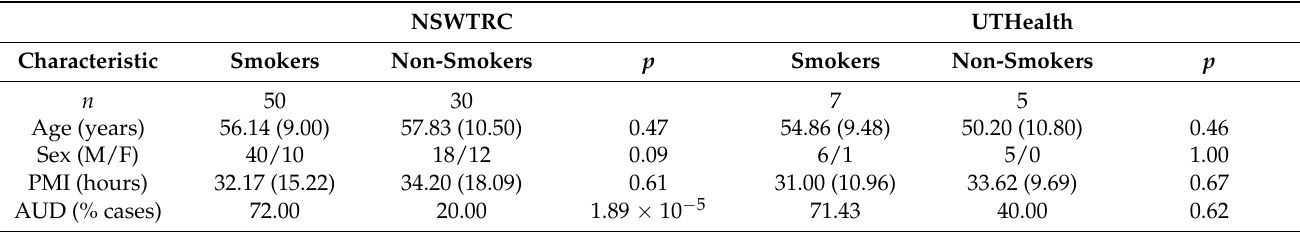
Table 1. Demographic data of tissue donors.